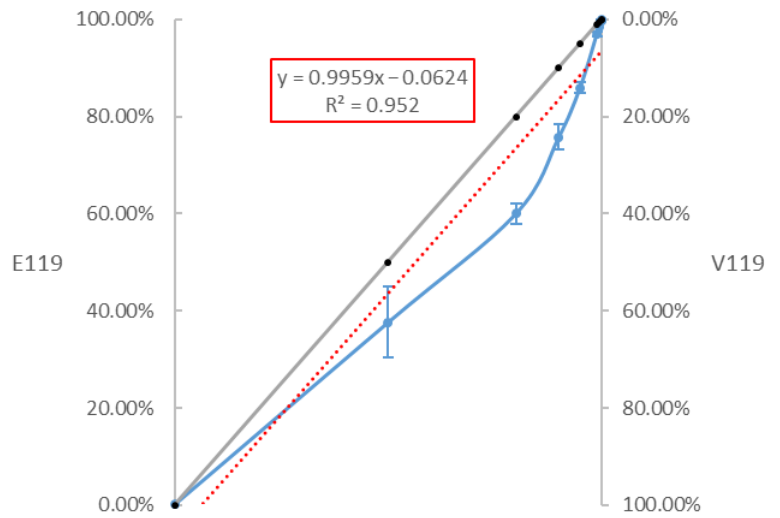
Figure 3. ddPCR results of the different proportions of the wild-type virus and the mutant virus. The grey line represents the theoretical percentages of the mixes, while the blue line is the observed results. The red line represents the linear trend line of the obtained